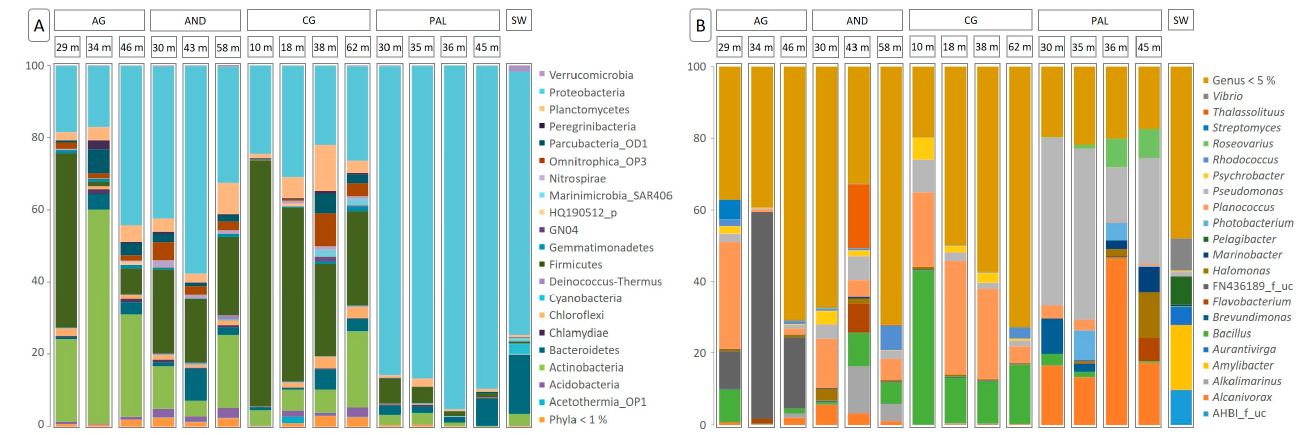
Figure 3. Distribution of relative abundances of the dominant microbial groups in the di ff erent aq- uifers and depths studied. ( A ): Phylum taxonomic level (representatives with relative abundance > 1% in at least one of the samples). ( B ): Genus taxonomic level (representatives with relative abundance > 5% in at least one of the samples).